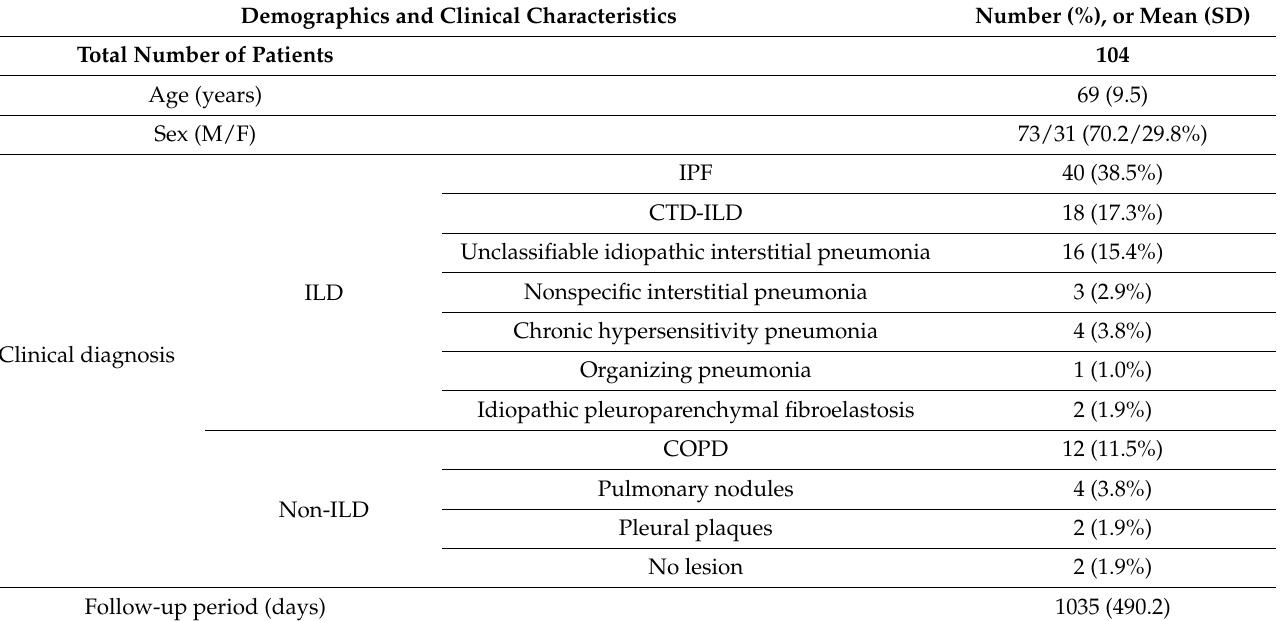
Table 1. Patient characteristics in clinical